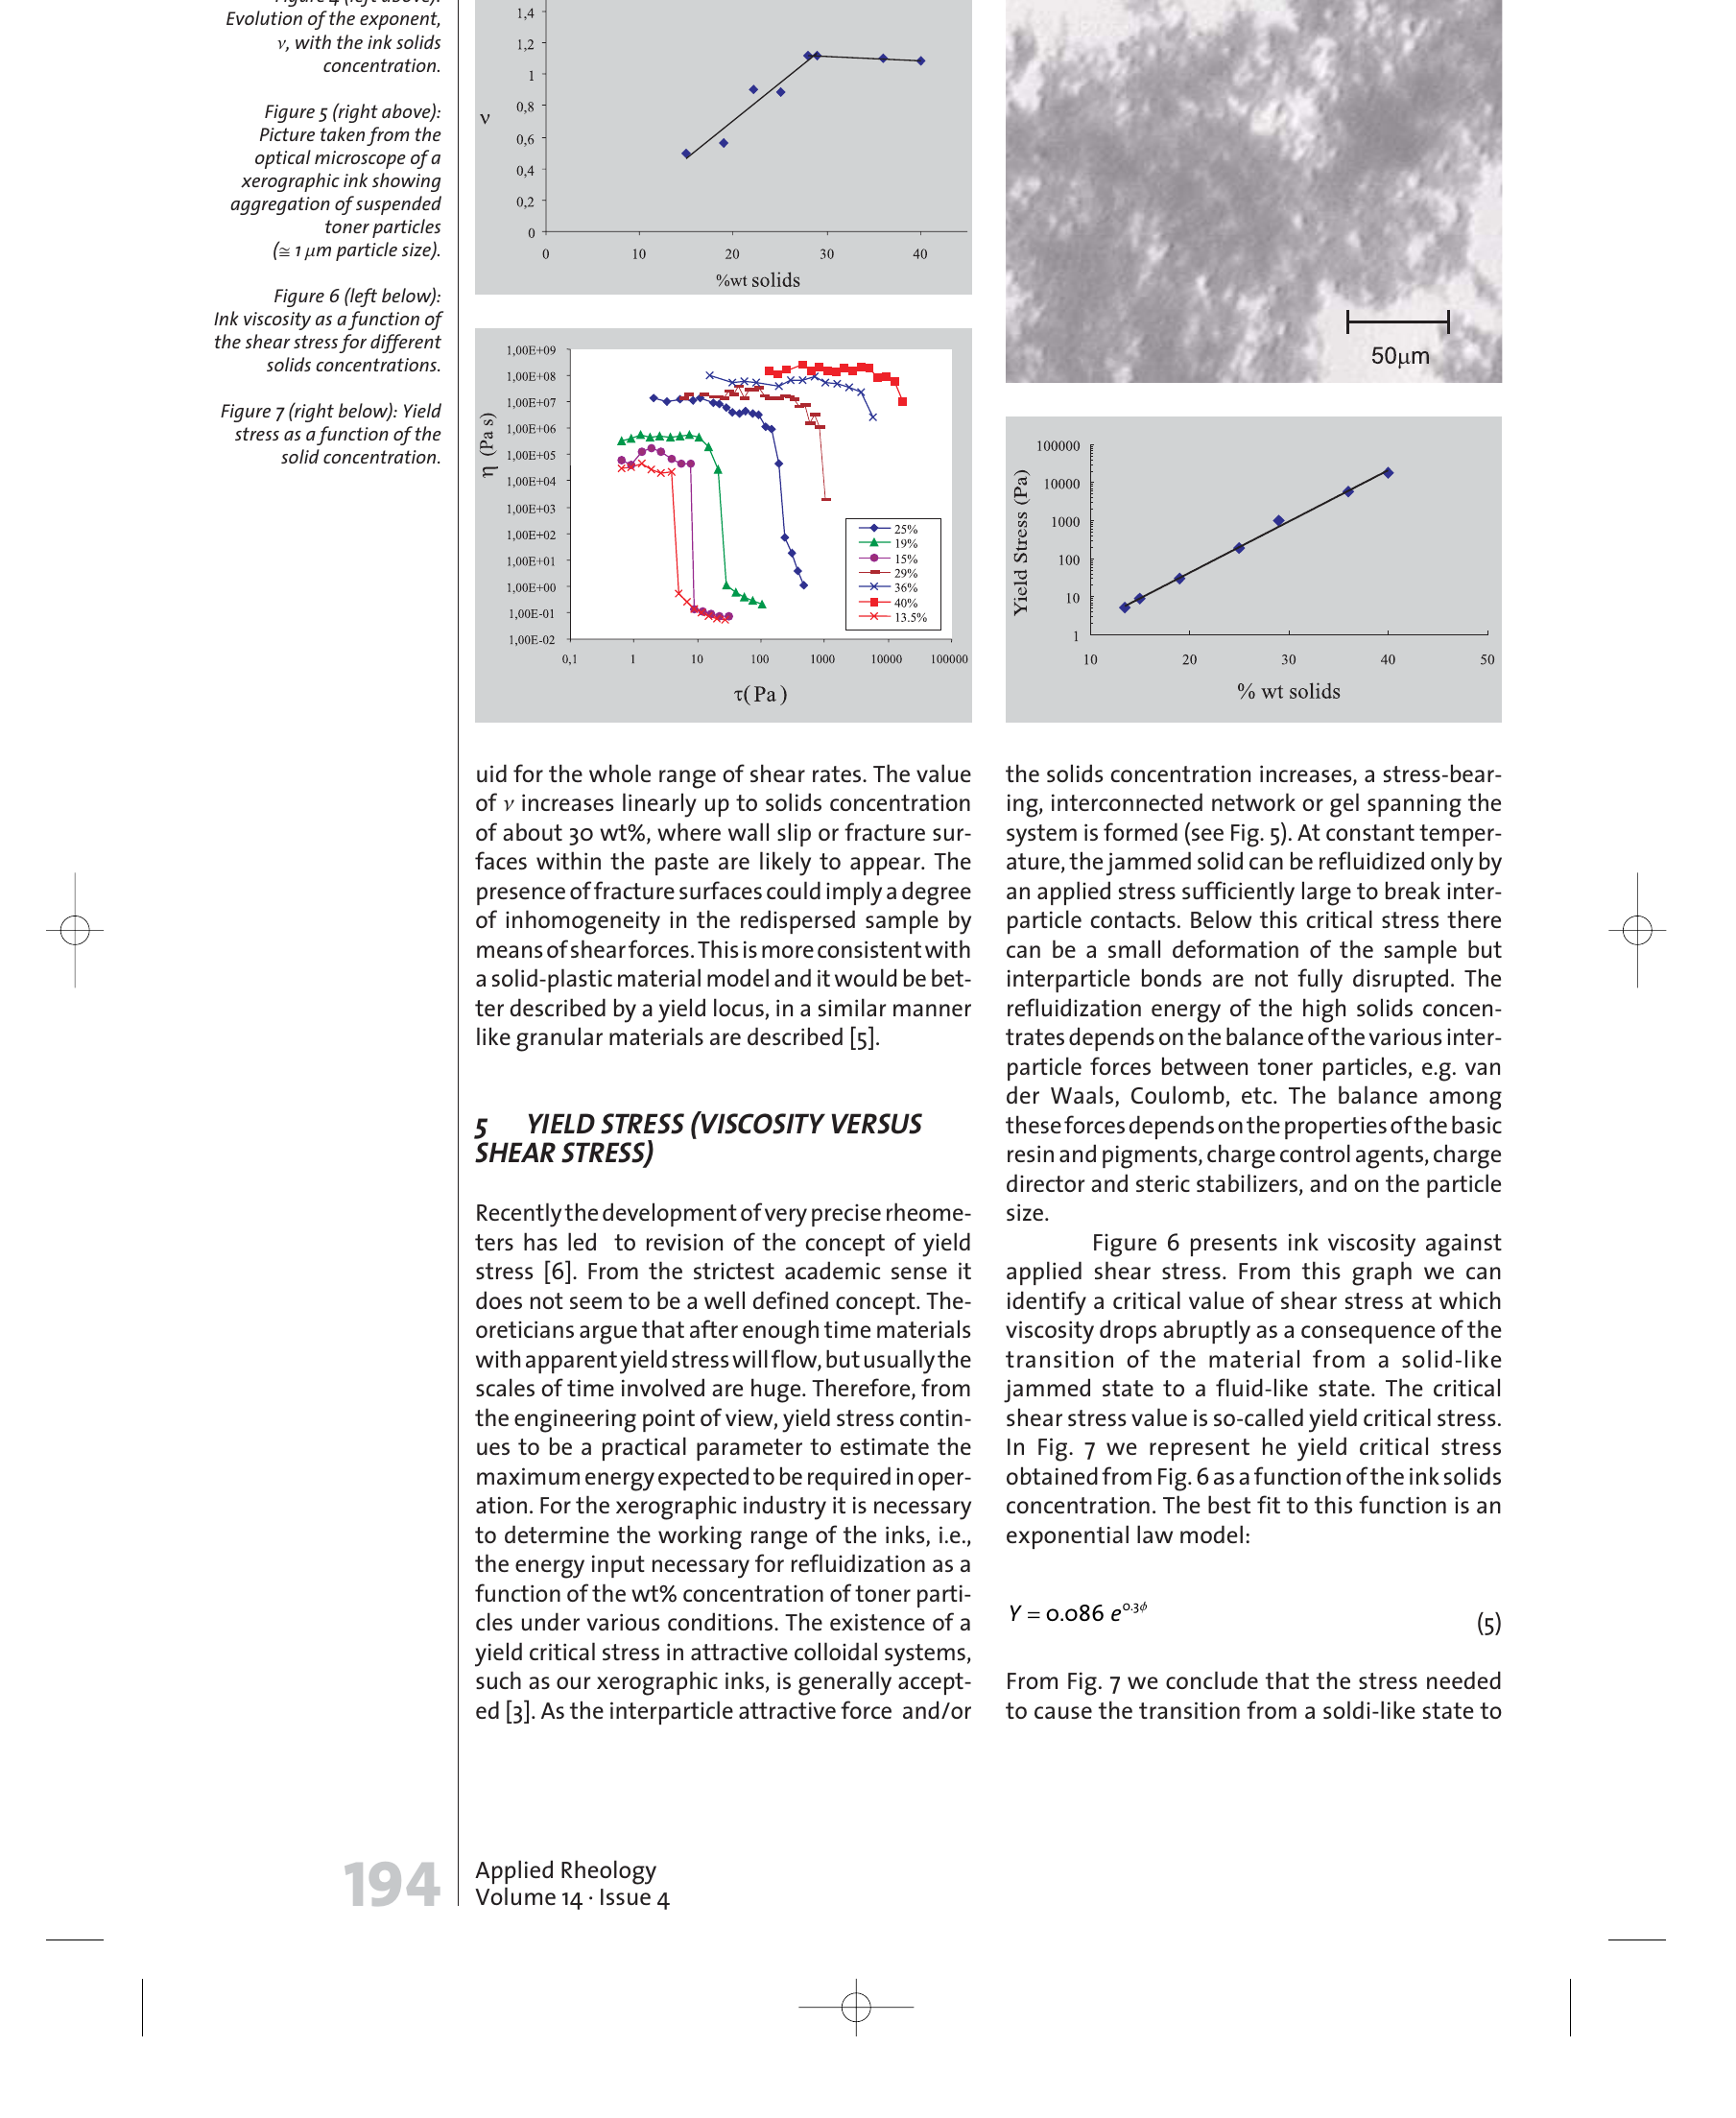
Figure 4 (left above): Evolution of the exponent, n , with the ink solids concentration. Figure 5 (right above): Picture taken from the optical microscope of a xerographic ink showing aggregation of suspended toner particles ( @ 1 m m particle size). Figure 6 (left below): Ink viscosity as a function of the shear stress for different solids concentrations. Figure 7 (right below): Yield stress as a function of the solid